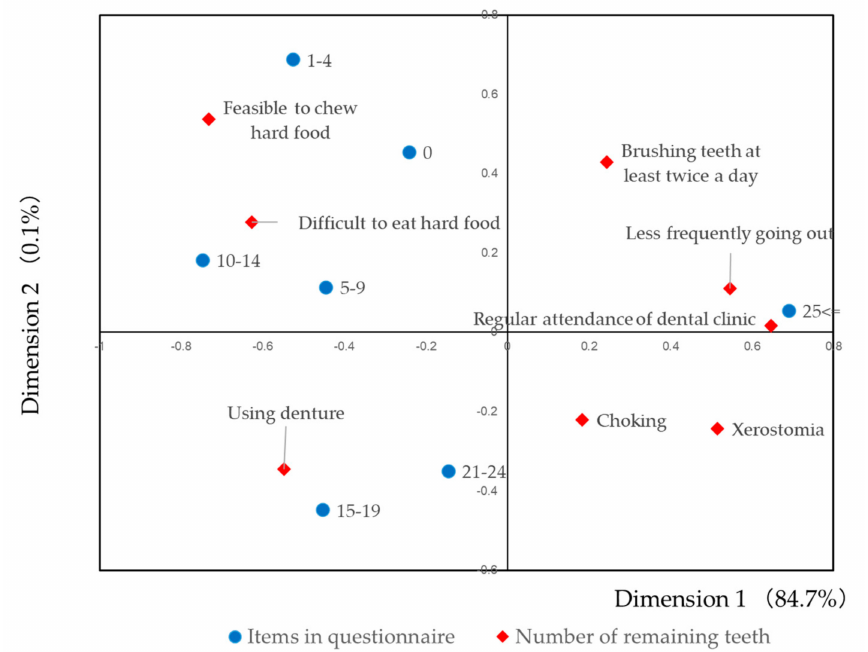
Figure 3. Correspondence analysis for the item response tendency. Subjects with high number of remaining teeth answered, “Regular attendance of dental clinic” and “Less frequently going